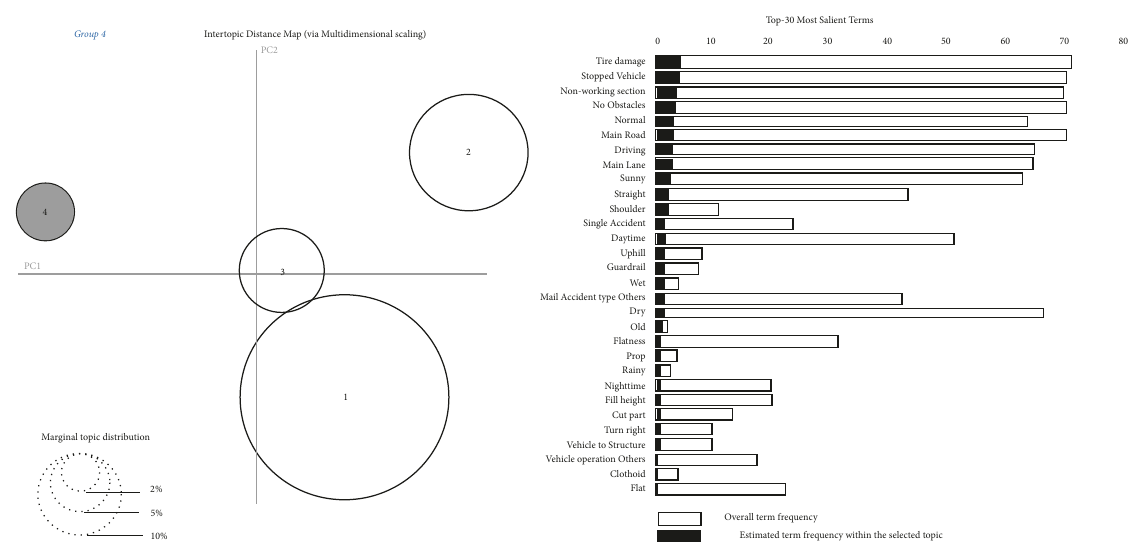
Figure 14: Vehicle factor group 4.